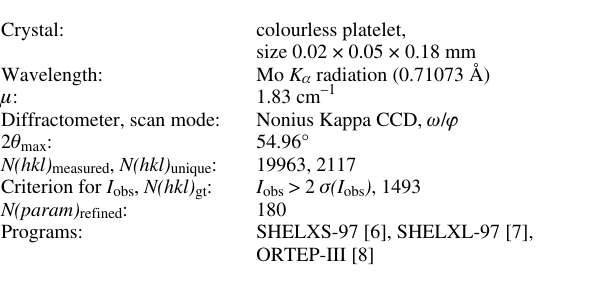
Table 1. Data collection and handling.